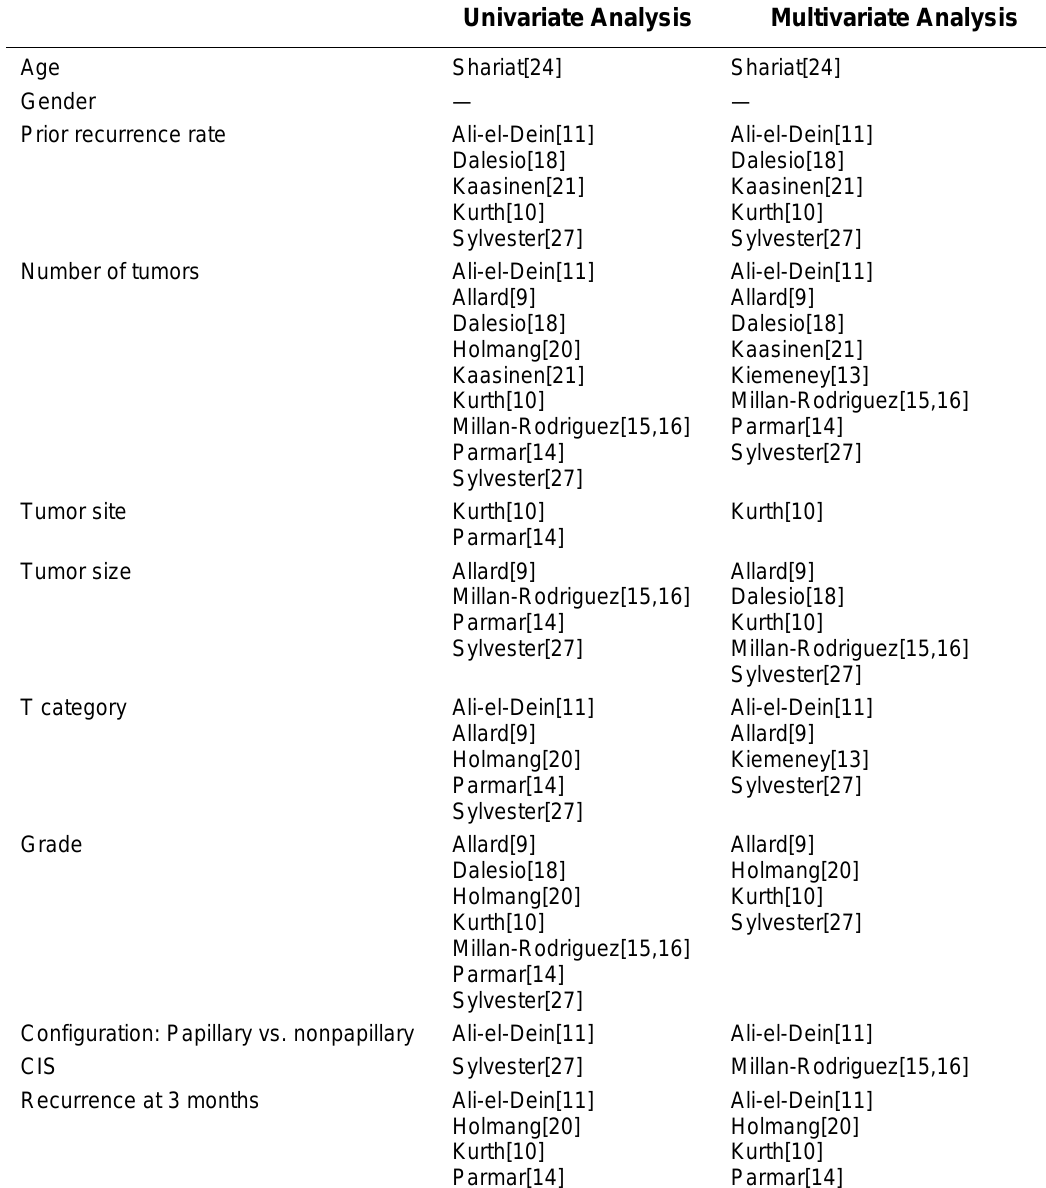
Prognostic Factors for